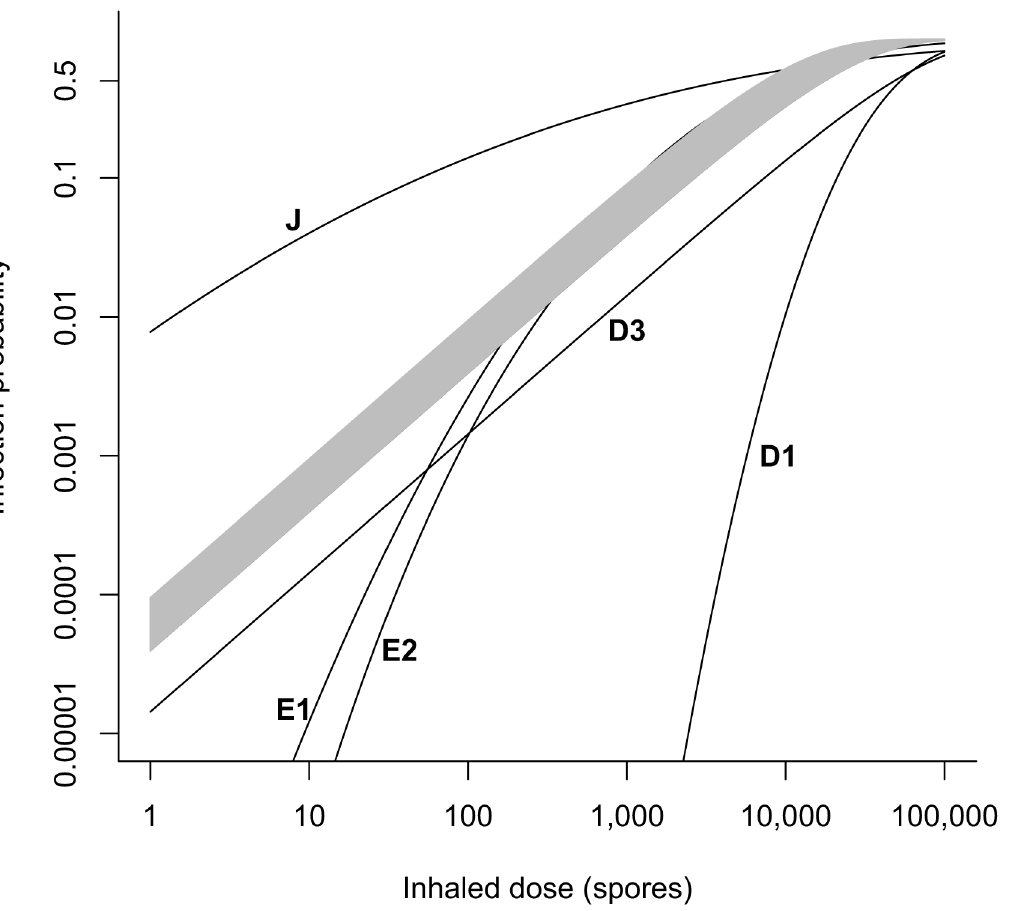
Figure 1. Comparison of dose-response models. Our best fit exponential model B4 based on Brachman data (shaded region=95% confidence range) is compared to selected other models from Table 1. Models E3 , E4 , and E5 fall entirely within the shaded region. Model B2 falls just below the lower boundary of the shaded region and is visually indistinguishable from it. We omit the curve for model D2 in this figure, as our fit of the exponential model to the Druett et al. data set ( D3 ) replaces the fit done by Haas ( D2 ).